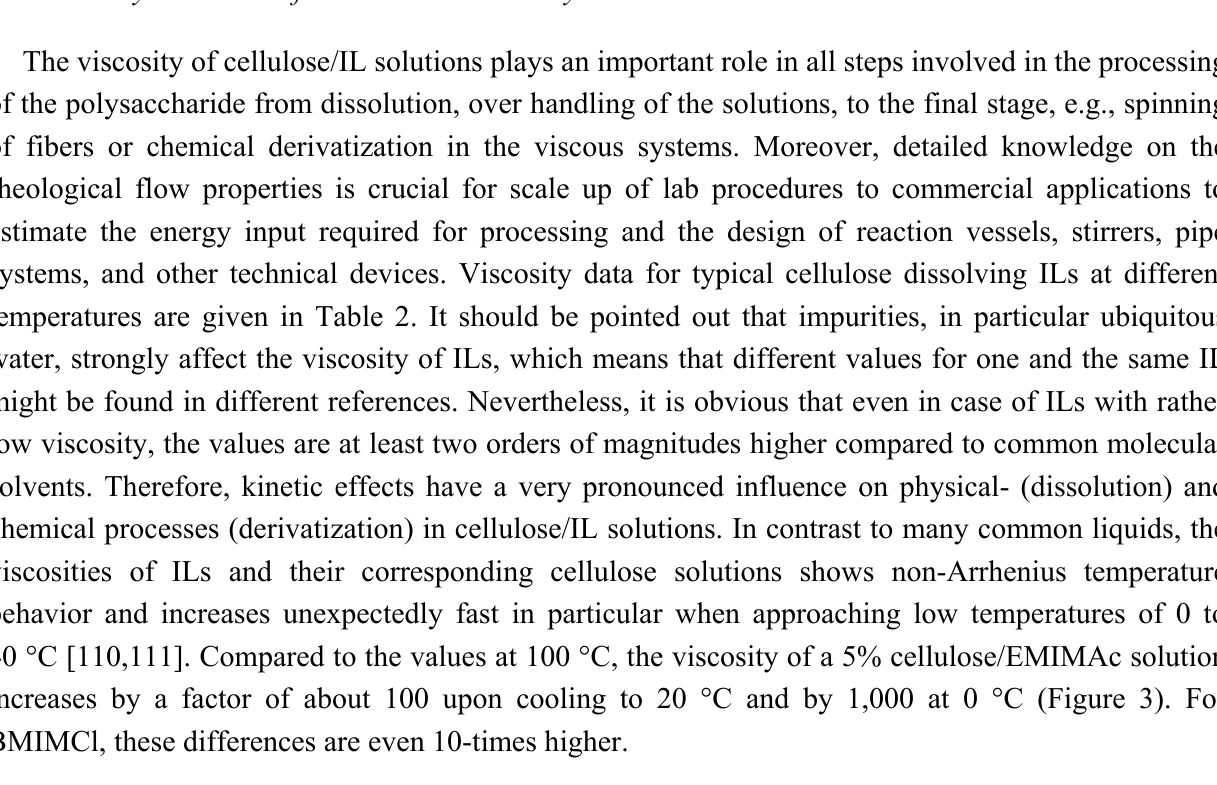
Table 2. Zero-shear rate viscosities of ionic liquids, water, and dimethylsulfoxide. Ionic Liquid a Temperature, Viscosity,